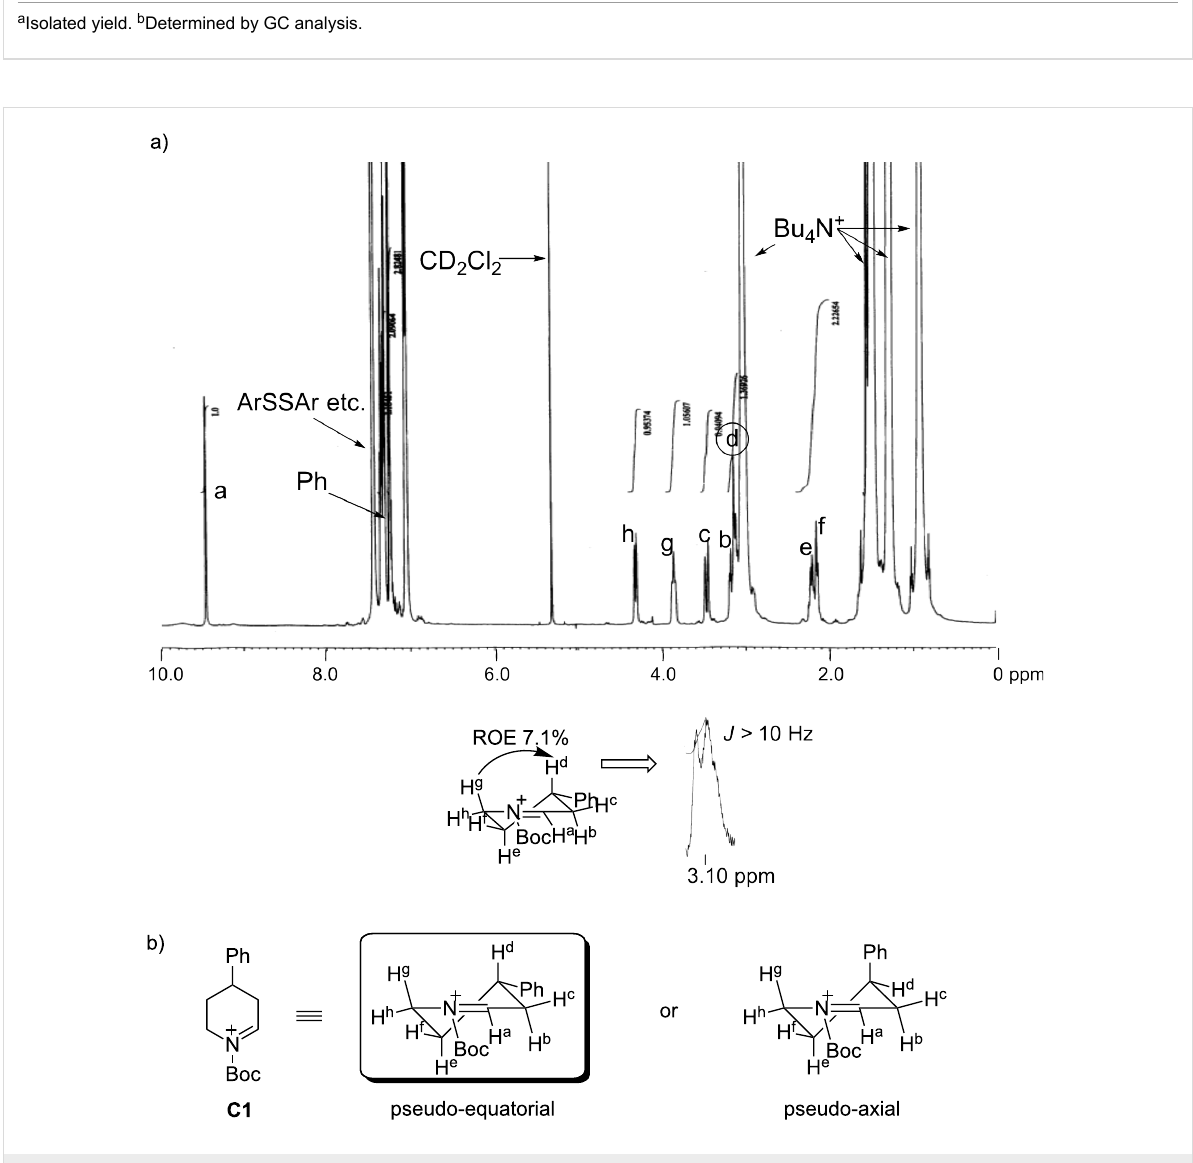
5 TMSCN a Isolated yield. b Determined by GC